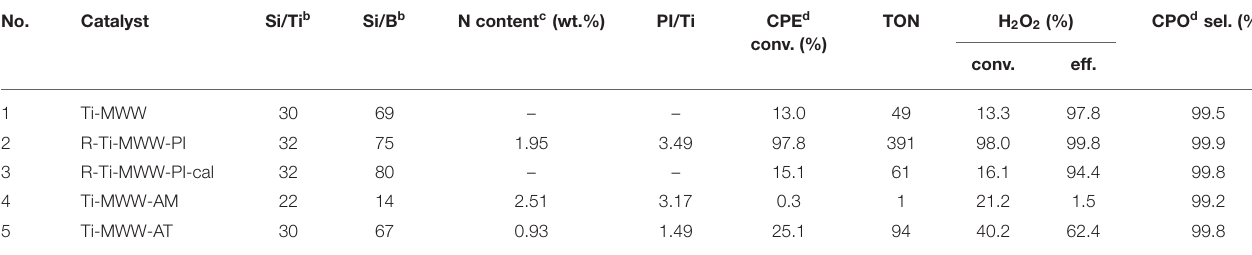
TABLE 2 | The catalytic performance of Ti-MWW related catalysts in the cyclopentene epoxidation reaction a . No. Catalyst